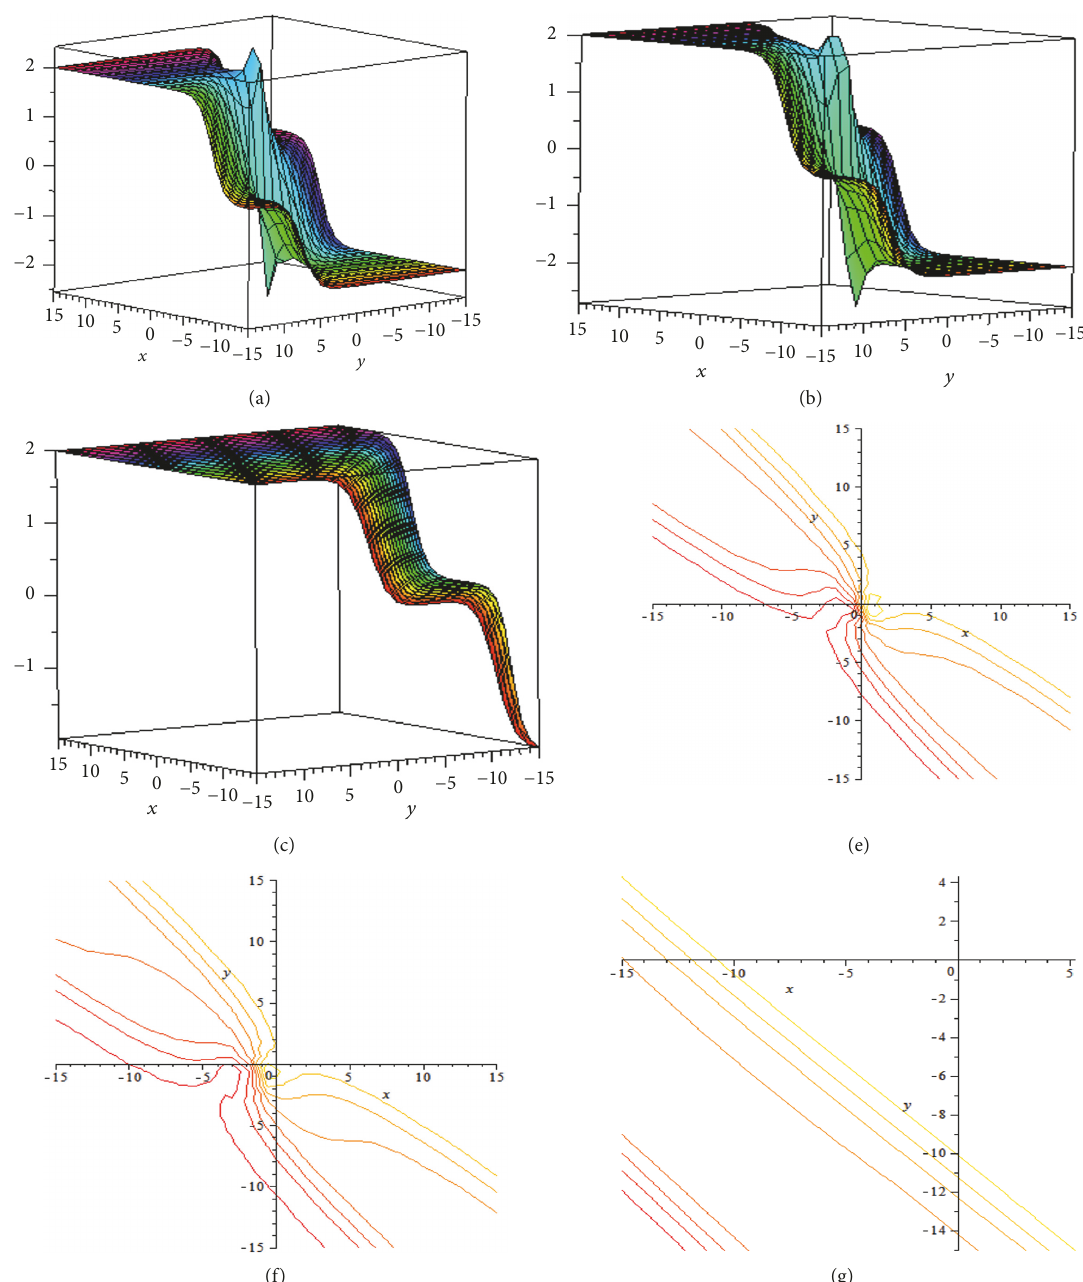
Figure 3: Proportion scenes of the solution equation (15) with (16) and (17) for the values of arbitrary constants are for 𝛼 2 = −1,𝛼 6 = 1,𝛼 7 = 2,𝛼 = 1, 𝛼 = 0,𝛼 = 1,𝛼 = 1,𝑘 = 1,𝑘 = 1, 𝑘 = 1 . (a), (b), and (c) represent 3D plots for (10) at 𝑡 = 0,5, 18 and 𝑧 = 0 , respectively. (e), 5 10 8 11 1 2 5 (f), and (g) Consistent contour plot of (a), (b), and (c).